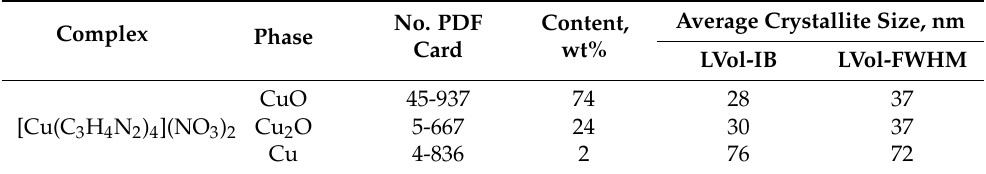
Figure 5. XDR data for solid products obtained by combustion of [Cu(C 3 H 4 N 2 ) 4 ](NO 3 ) 2 complex under air. Table 3. XRD data for solid products obtained by combustion of [Cu(C 3 H 4 N 2 ) 4 ](NO 3 ) 2 complex